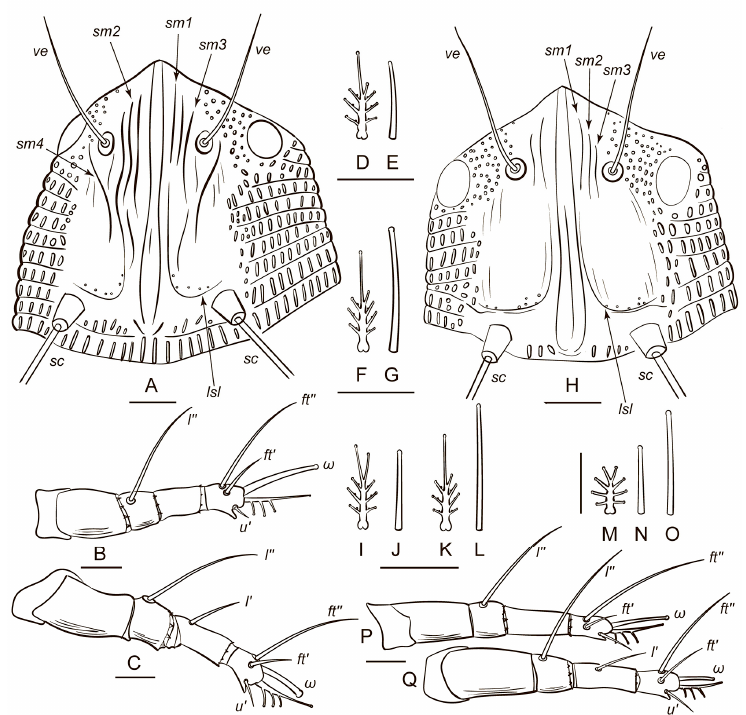
Figure 4. Drawings of prodorsal shields, legs, and tarsal appendages of Novophytoptus zuluensis n. sp. ( A – G ) and N. limpopoensis n. sp. ( H – Q ). ( A )—Female prodorsal shield, ( B , C )—legs II and I, ( D )—empodium I, ( E )—tarsal solenidion I, ( F )—empodium II, ( G )—tarsal solenidion II, ( H )—female prodorsal shield, ( I )—empodium I, ( J )—tarsal solenidion I, ( K )—empodium II, ( L )—tarsal solenid-